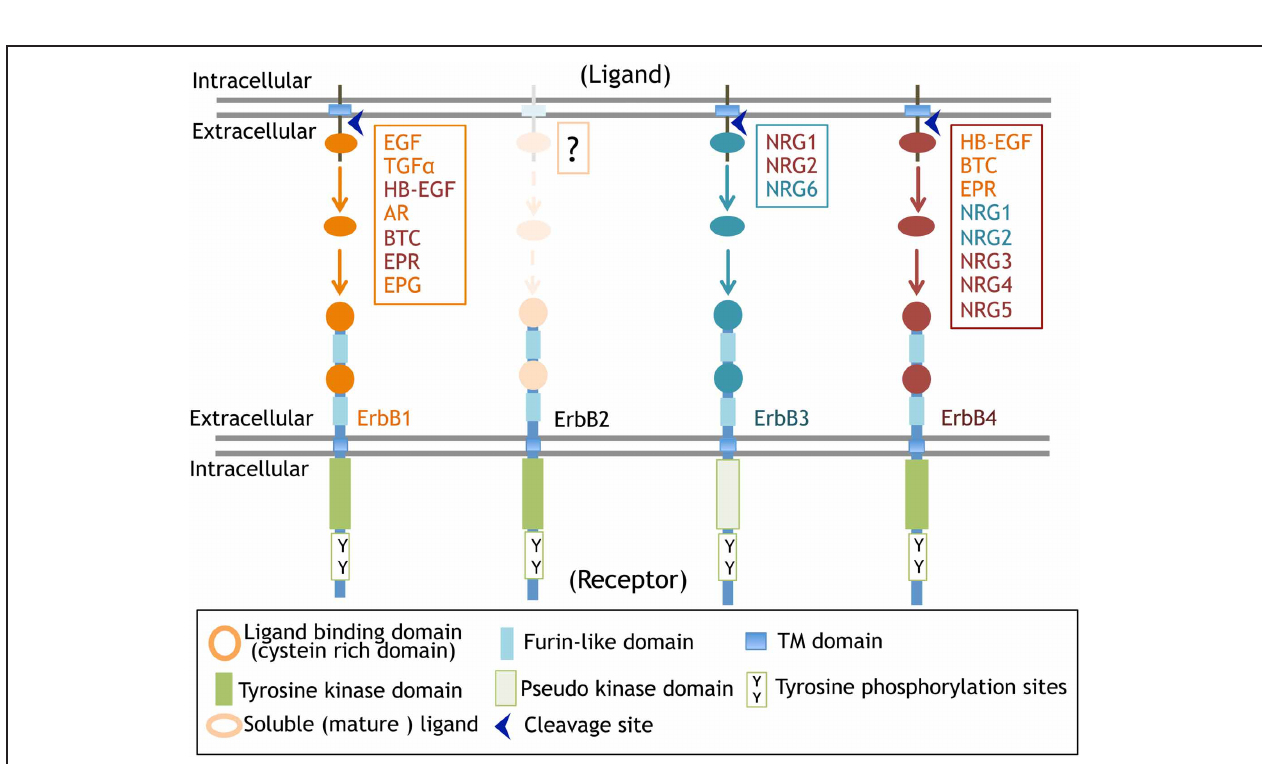
domain and allows it to phosphorylate the cytoplasmic region of the ErbB partner. The phosphorylated tyrosine residues recruit various adaptors/effectors that induce intracellular signals.